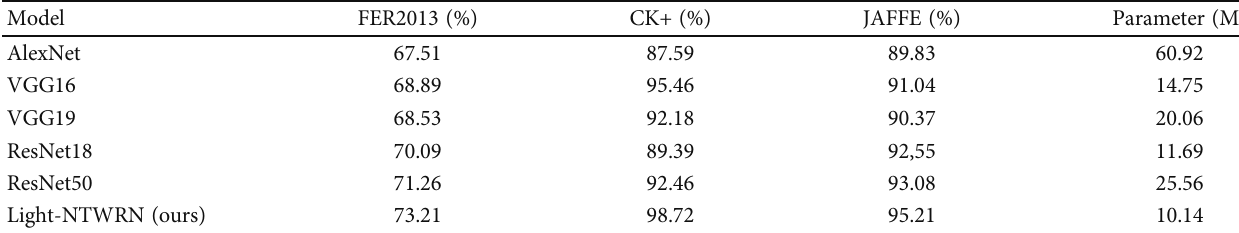
(c) Confusion matrix on the JAFFE dataset Figure 11: Confusion matrix. Table 6: Comparison experiments of mainstream algorithms.